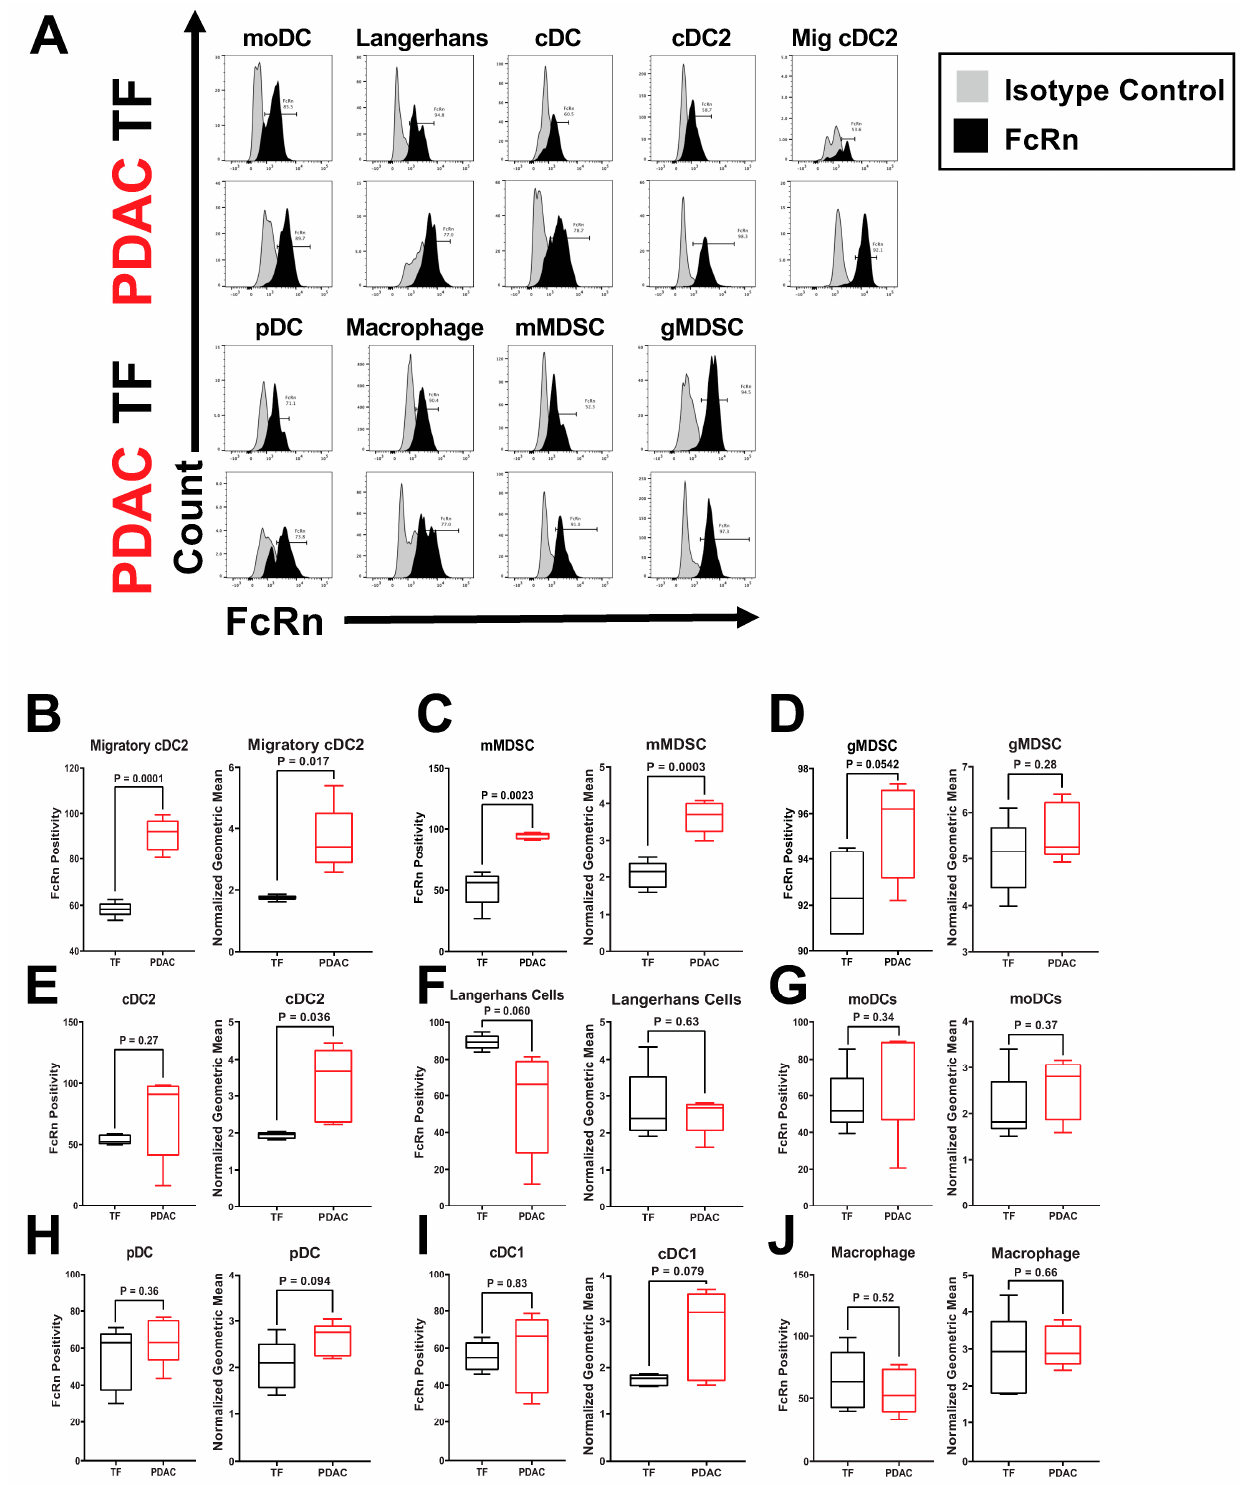
Figure 2. FcRn Positivity and Expression are Altered in Murine Splenocyte Immune Populations. Splenocytes from five different tumor-free (TF) or pancreatic tumor-bearing (PDX-1-Cre, LSLKras G12D , LSL-Trp53 − / − ) mice were permeabilized and stained with either anti-FcRn or an isotype control antibody. Biological replicates represent staining and analyses from five different animals per group. ( A ) Representative histograms of FcRn and isotype control are provided for TF and pan- creatic tumor-bearing mice with isotype peaks in gray and FcRn peaks in black. Each cell type was assessed for FcRn positivity and the mean fluorescence intensity (MFI). Quantification of splenocyte